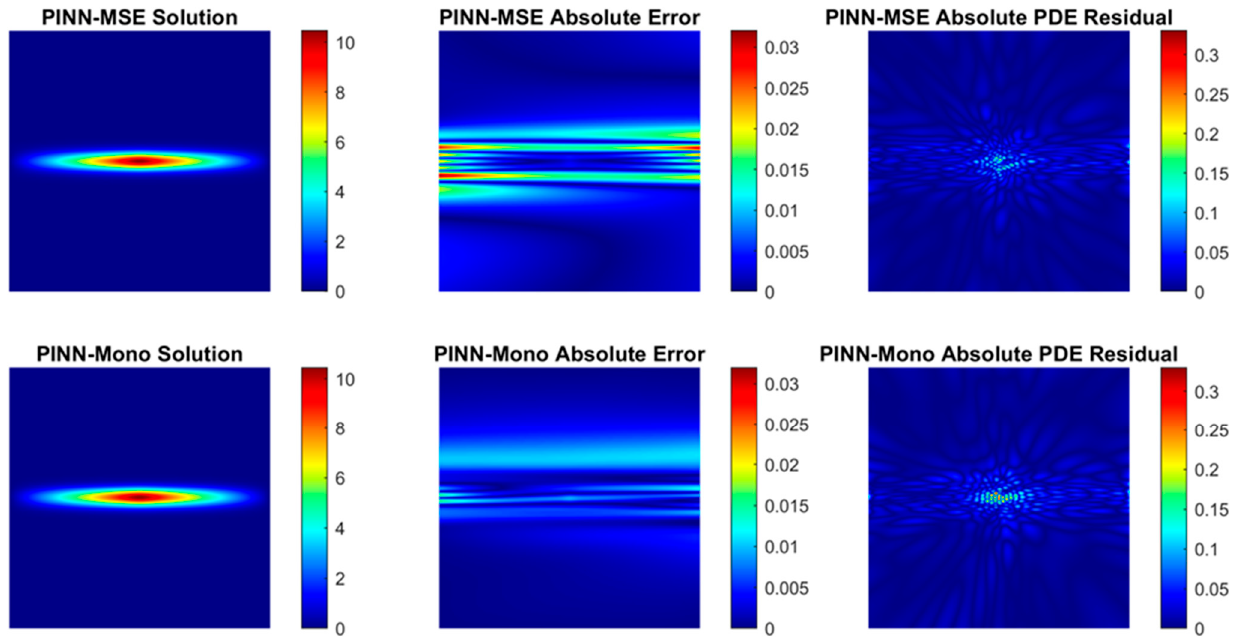
Table 1. Summary of computational results for case 1: 𝜃 = 0 .